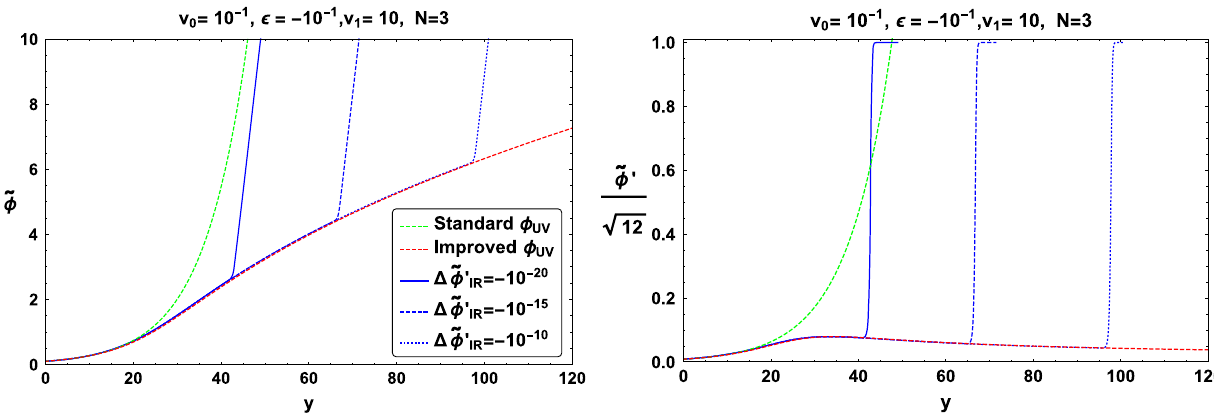
cases, as expected, but the lowest order UV solution disagrees severely. Our approximate UV solution outlined above continues to track the unstable UV fixed point up until the IR condensate region develops